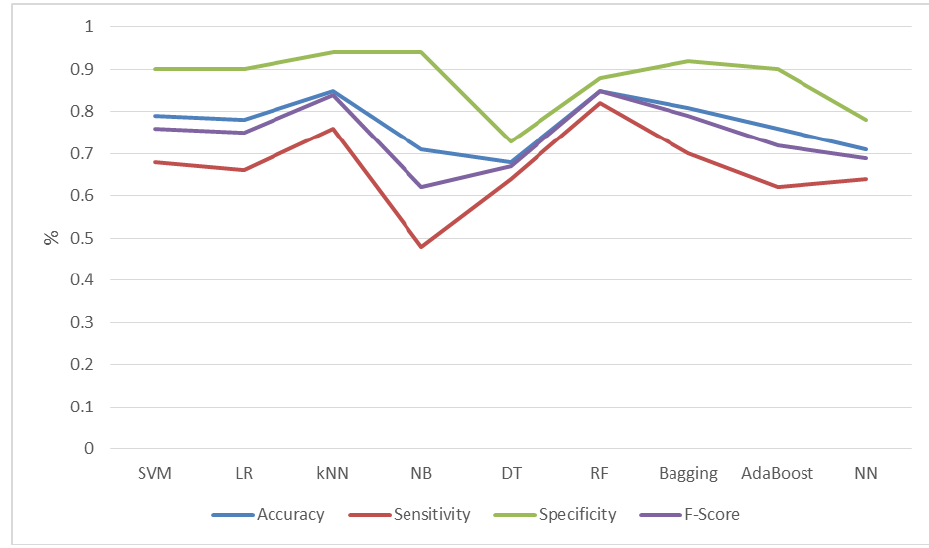
Figure 4. Results using 10 features whose correlation > 0.1.